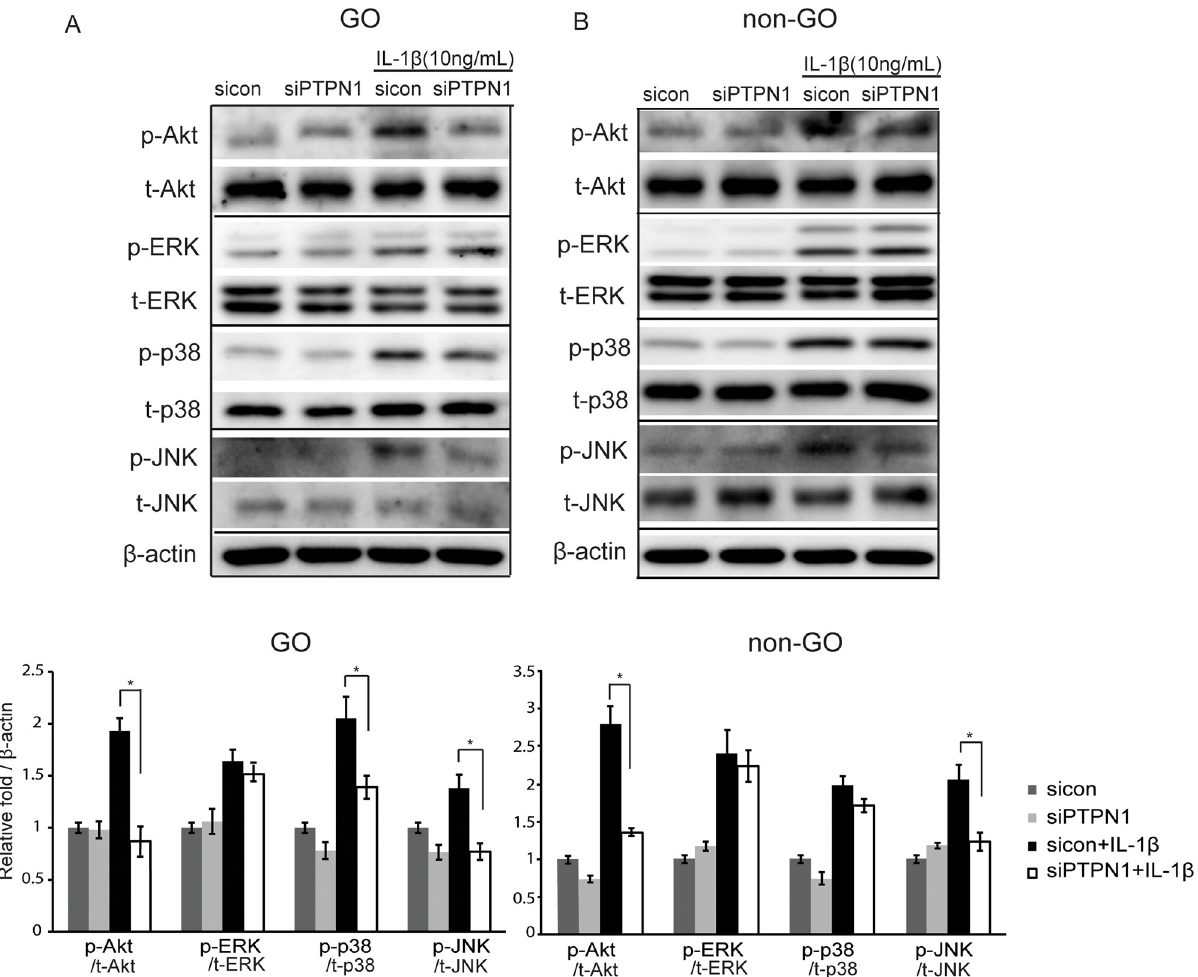
Fig 6. Effect of PTP1B suppression on signalling pathways in orbital fibroblasts. GO and non-GO cells were transfected with sicontrol or siPTPN1 for 24 hours and then exposed to IL-1 β (10 ng/mL) for 1 hour. Phosphorylated and total Akt, ERK, p38, and JNK were determined by western blotting in GO fibroblasts (A) and non-GO fibroblasts (B). Experiments were performed in three GO and non-GO cells from different individuals. Representative bands are shown. Data in the columns indicate the mean density ratio ± SD by densitometry normalised to the level of β -actin in the same sample. Differences between sicontrol and siPTPN1 are indicated ( � p < 0.05). See S3 Fig for uncropped